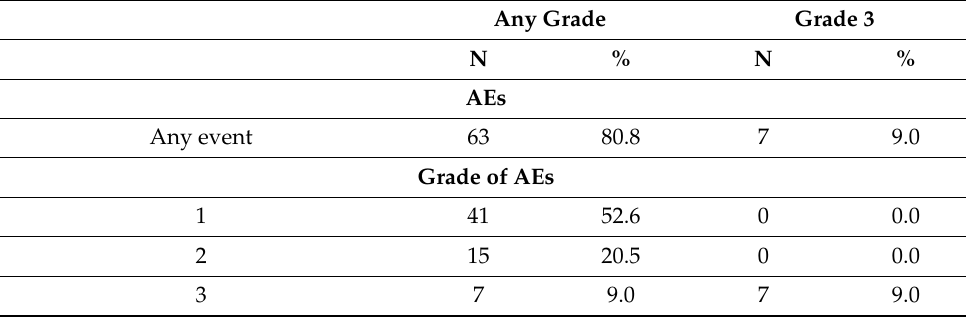
Table 3. Adverse Events in the whole population treated with